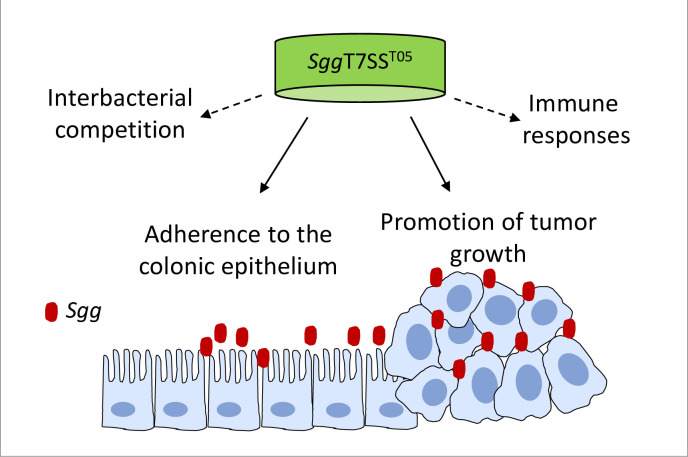
A working model for how SggT7SST05 contributes to Sgg pathogenicity in the colon.